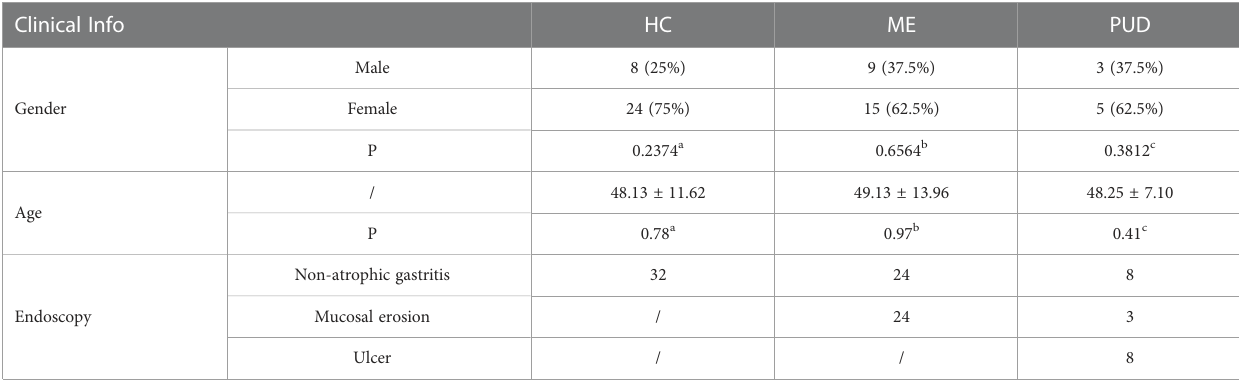
TABLE 1 Statistics of clinical characteristics of